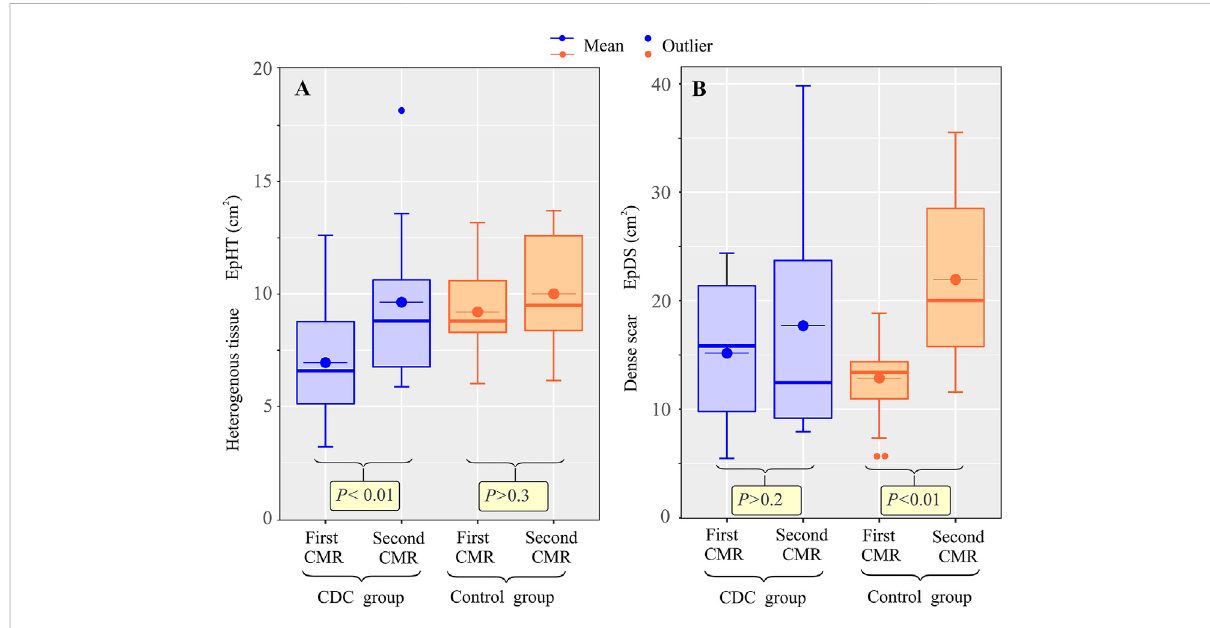
FIGURE 4 Effect of CDCs on epicardial ischemic scar composition. Boxplot showing the change in epicardial heterogeneous tissue, EpHT, (A) and dense scar, EpDS, (B) between the fi rst and second CMR in the treatment and control